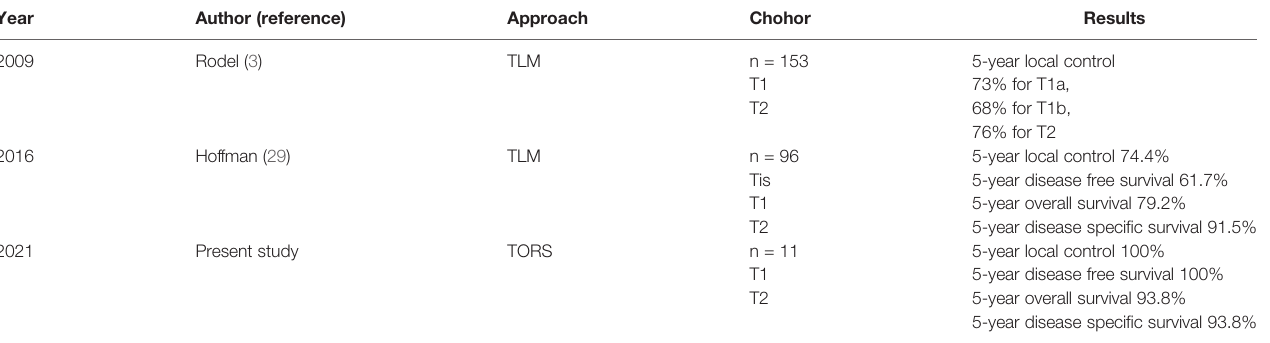
TABLE 5 | Results of transoral surgery for fresh case of glottic cancer with AC